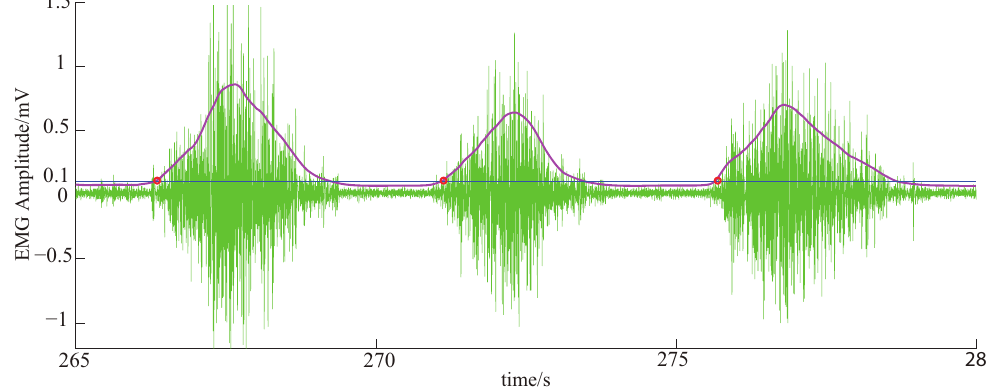
Figure 2. Definition of the time when the motion starts. The green waves are the raw EMG signals, the red line is smoothed and normalized EMG signals after adjusted for the filter delay, the blue line is the positions where the normalized EMG value is 0.1, and the red circles are the time when the motion